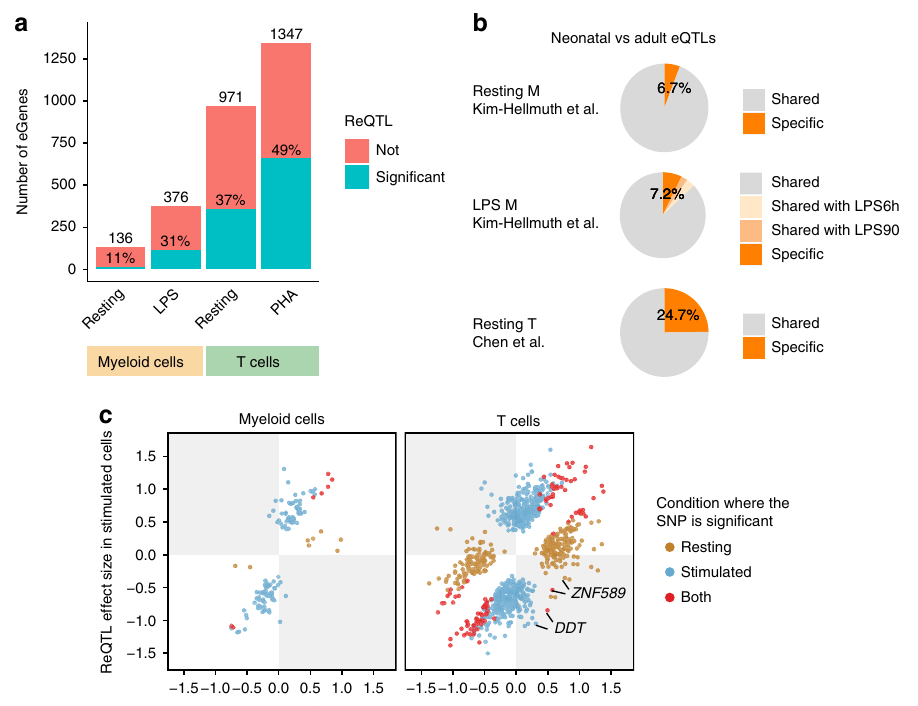
Fig. 2 Cis -eQTLs and response eQTLs (reQTLs) in myeloid cells and T cells. a A bar plot shows the number of genes with signi fi cant cis -eQTLs (eGenes) at a 5% false discovery rate (FDR) identi fi ed in each cell type and treatment group (on x -axis). Percentages on each bar indicate the proportion of eGenes with signi fi cant reQTLs at 5% FDR ( ‘ Methods ’ ). b Three pie charts show the proportions of eQTLs that were speci fi c to neonates in resting myeloid cells ( n = 116 biologically independent samples), LPS-stimulated myeloid cells ( n = 125), and resting T cells ( n = 126), respectively. Neonatal speci fi c eQTLs were de fi ned by comparing the eQTLs in our study with that identi fi ed in resting and LPS-stimulated (90 min or 6 h) monocytes obtained from adults (Kim- Hellmuth et al. 11 , n = 134), and that in naïve adult T cells (BLUEPRINT project 22 , n = 125; ‘ Methods ’ ). Myeloid eQTLs that were not tested in the Kim- Hellmuth et al. study (31 and 44 in resting and stimulated conditions, respectively) or T-cell eQTLs that were not tested in the Chen et al. study (332 in resting T cells) were excluded in the analysis. c Two point plots show effect sizes (difference in gene expression in s.d. per allele) of signi fi cant reQTLs in resting ( x -axes) and stimulated conditions (y-axes) in two cell populations: myeloid cells (left) and T cells (right). A gene might have two dots indicating two independent top SNPs ( ‘ Methods ’ ). Colours indicate the condition in which the SNP was signi fi cant. ReQTLs of DDT and ZNF585 in the grey quadrants (red dots) show opposite directions of eQTL effects across